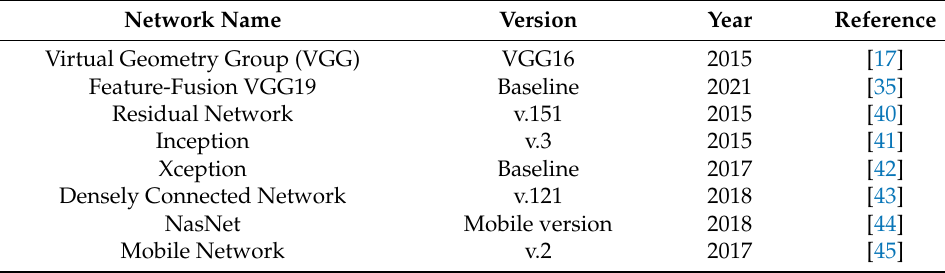
Table 2. DL networks employed in the present study.